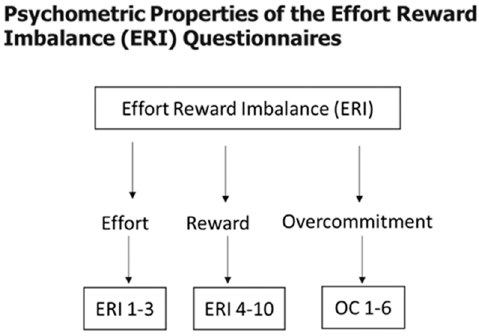
Figure 2. Psychometric properties showing effort–reward imbalance (ERI) questionnaires. Effort– reward imbalance survey questionnaires included three effort questions (1–3), seven reward